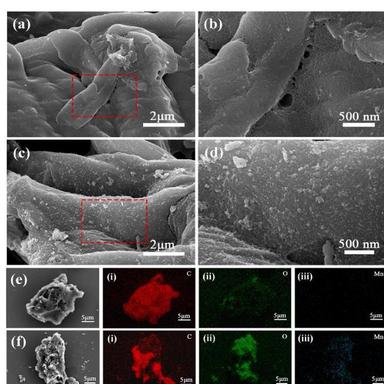
SEM images of SAC (a, b) and SAC-MnO-0.020 (c, d). Elemental mapping images of SAC (e) and SAC-MnO-0.020 (f).